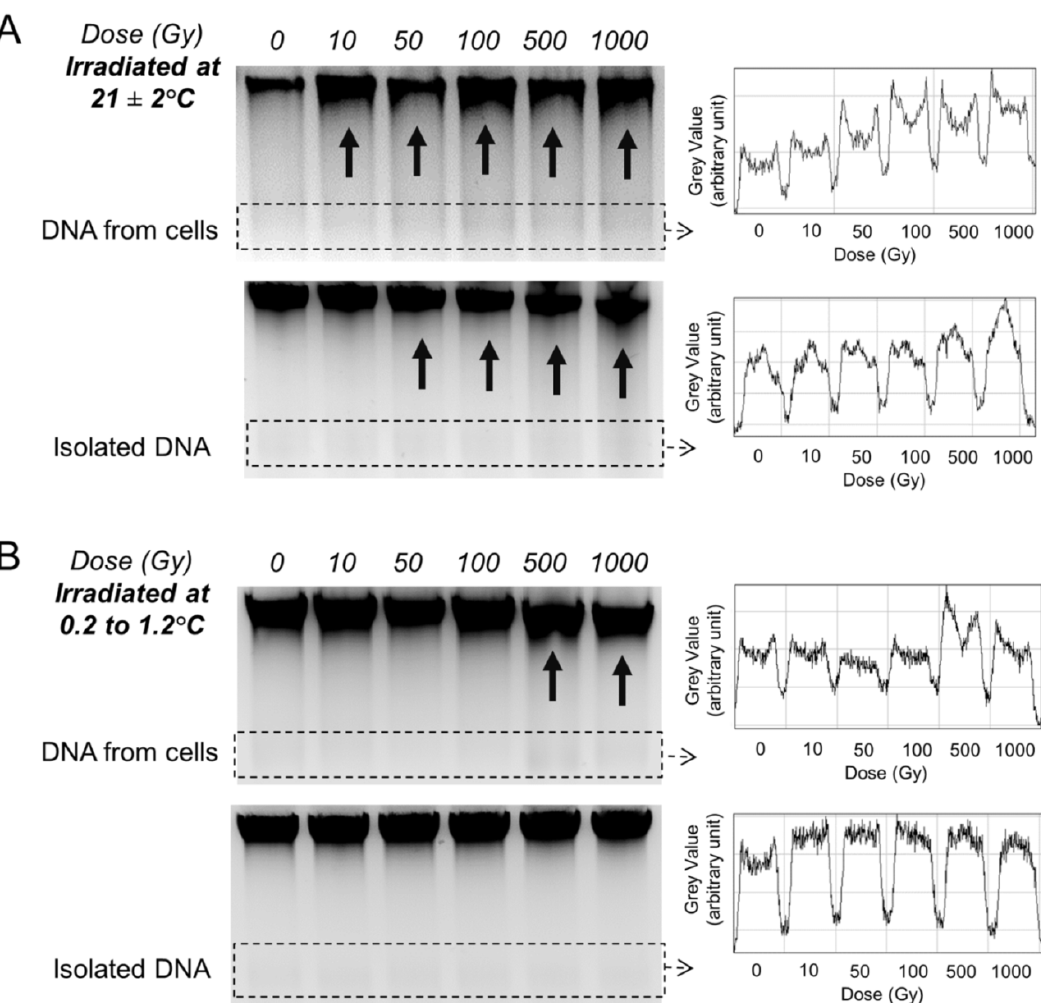
Figure 2. Gel electrophoresis of the DNA templates. ( A ) Equal amounts of DNA extracted from JURKAT cells (260 ng/lane, top image) or isolated total DNA (1 μ g/lane, bottom image) irradiated at room temperature were loaded into a 1.5% agarose gel for electrophoresis. Similarly, the same procedure was performed using ( B ) DNA extracted from JURKAT cells (1 μ g/lane, top image) or isolated DNA (1 μ g/lane, bottom image) irradiated at low temperature. The level of DNA fragmentation of each sample (boxed area) is demonstrated by the line profile plot presented next to the gel image. Arrows indicate DNA smearing or size reduction of the major band. The data show a radiation dose-dependent increase in DNA fragmentation that can be reduced by lowering the irradiation temperature from ~21 °C to 0.2–1.2